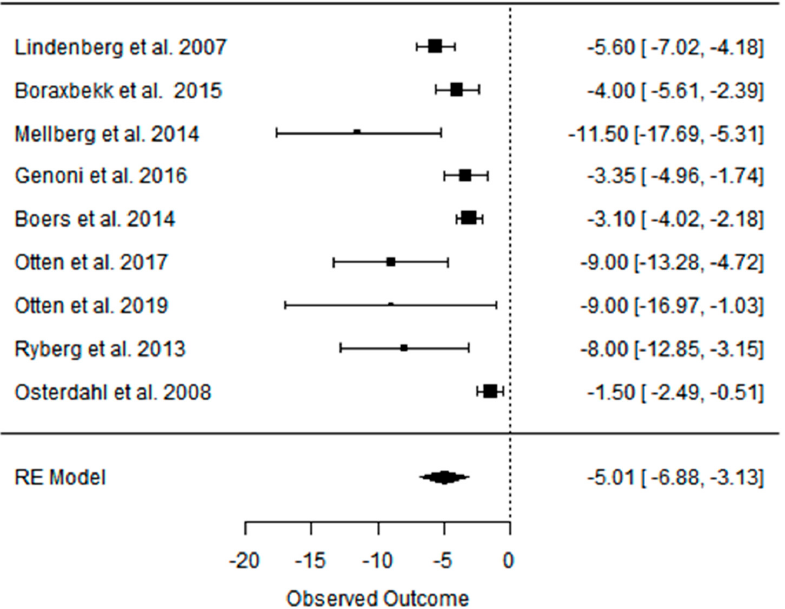
Figure A7. Forest plot of the effect of a PDs on waist circumference (cm) in the short term (weighted mean difference).